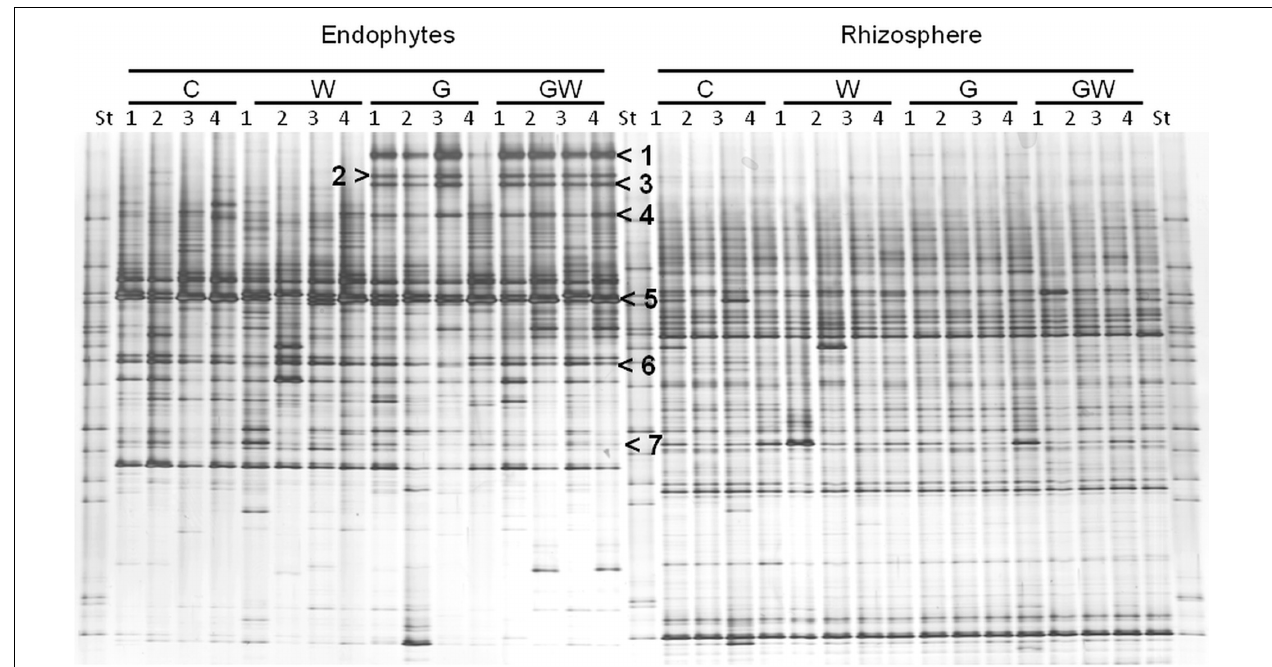
FIGURE 2 | DGGE fingerprints of ITS fragments showing the endorhiza and rhizosphere fungal communities of maize plants from the treatments C, W, G, and GW. C, maize plant grown in Haplic Chernozem, natural source of different mycorrhizal species; W, maize plants characterized by 3 weeks root feeding by WCR larvae; G, maize plants with GI inoculum added before sowing; GW, maize plants mycorrhized by GI and characterized